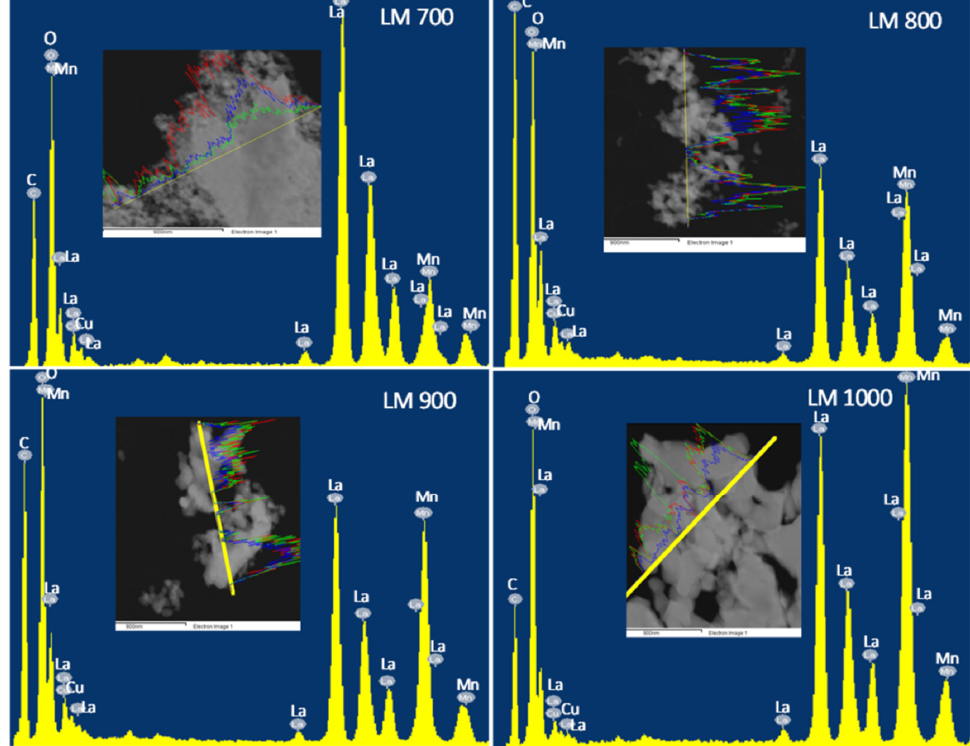
Figure 6. EDX plots of LaMnO 3 ( ■ La, ■ Mn, and ■ O). Table 4. Summary of the elemental compositions detected using EDX.